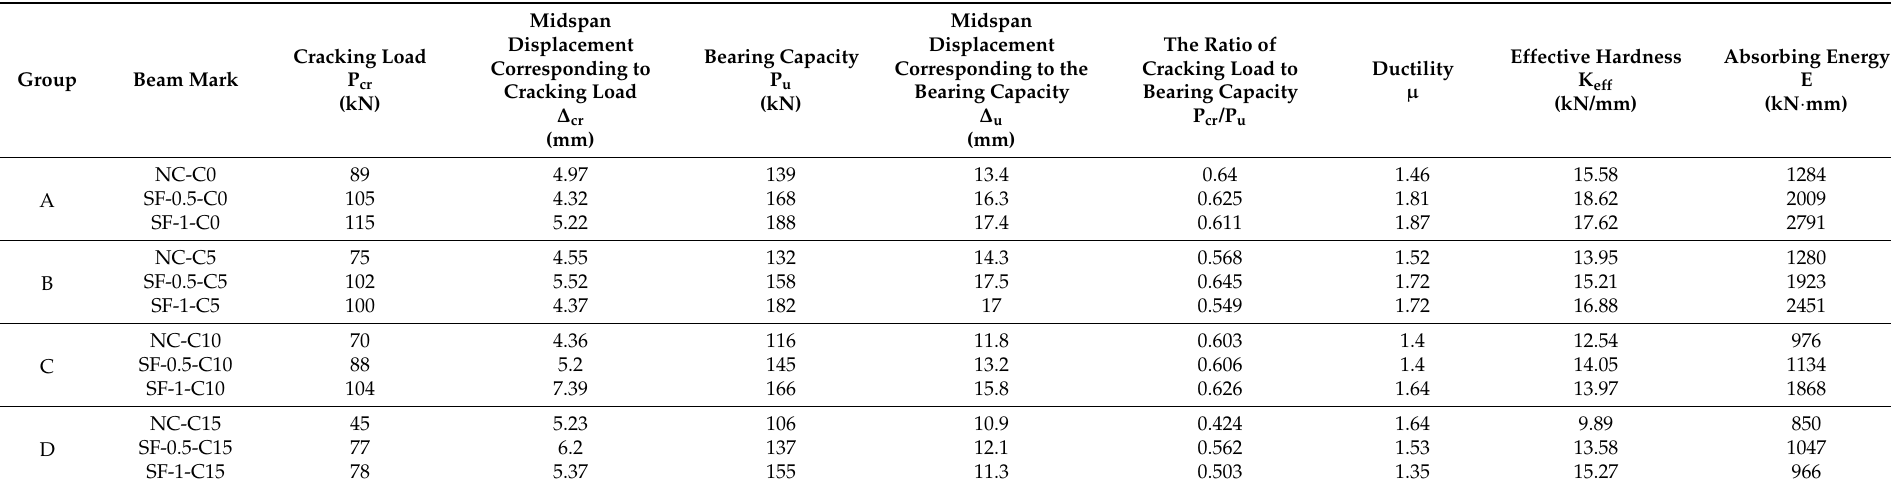
Table 6. Summary of the test